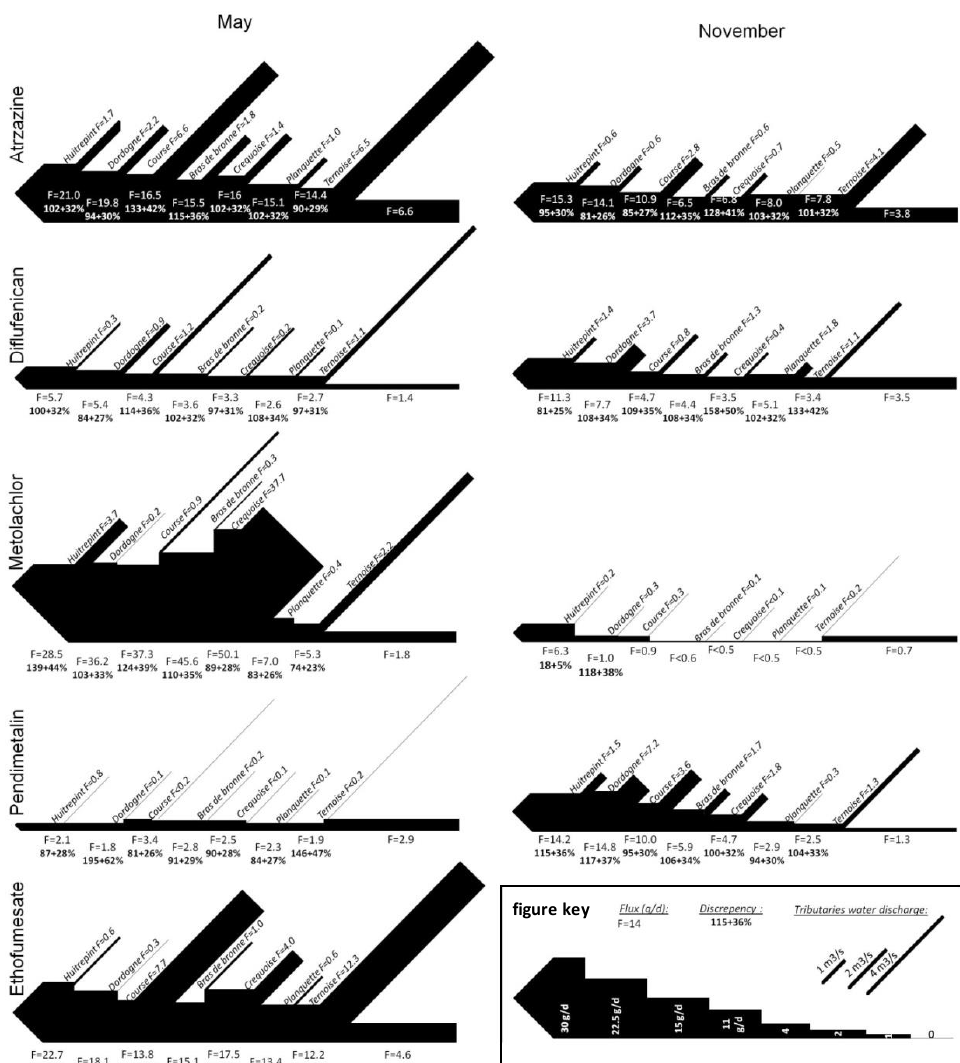
Figure 3. Sketches of cumulative mass balance analysis for May and November 2016 seasonal campaigns along the Canche River transect. For clarity, sketches of February and July 2016 investigated periods are not shown here. In addition, during February and July 2016 diflufenican and pendimethalin were not detected or at too low level for reliable mass balance analysis. Data of the missing campaigns is provided in Tables S3 and S4. For figure reading, please note that the widths of arrows are proportional to the flux of the respective compound and lengths of arrows are proportional to the water discharge (compare also to the example given in the “figure key” in the right lower window). Therefore, wide and short arrows refer to the highest concentrations of dissolved substances for which the toxicological effect is expected to be the most important. The bold numbers indicated the discrepancy between the sum of both tributaries and the flux at the closest effluent point (expressed in percentage).